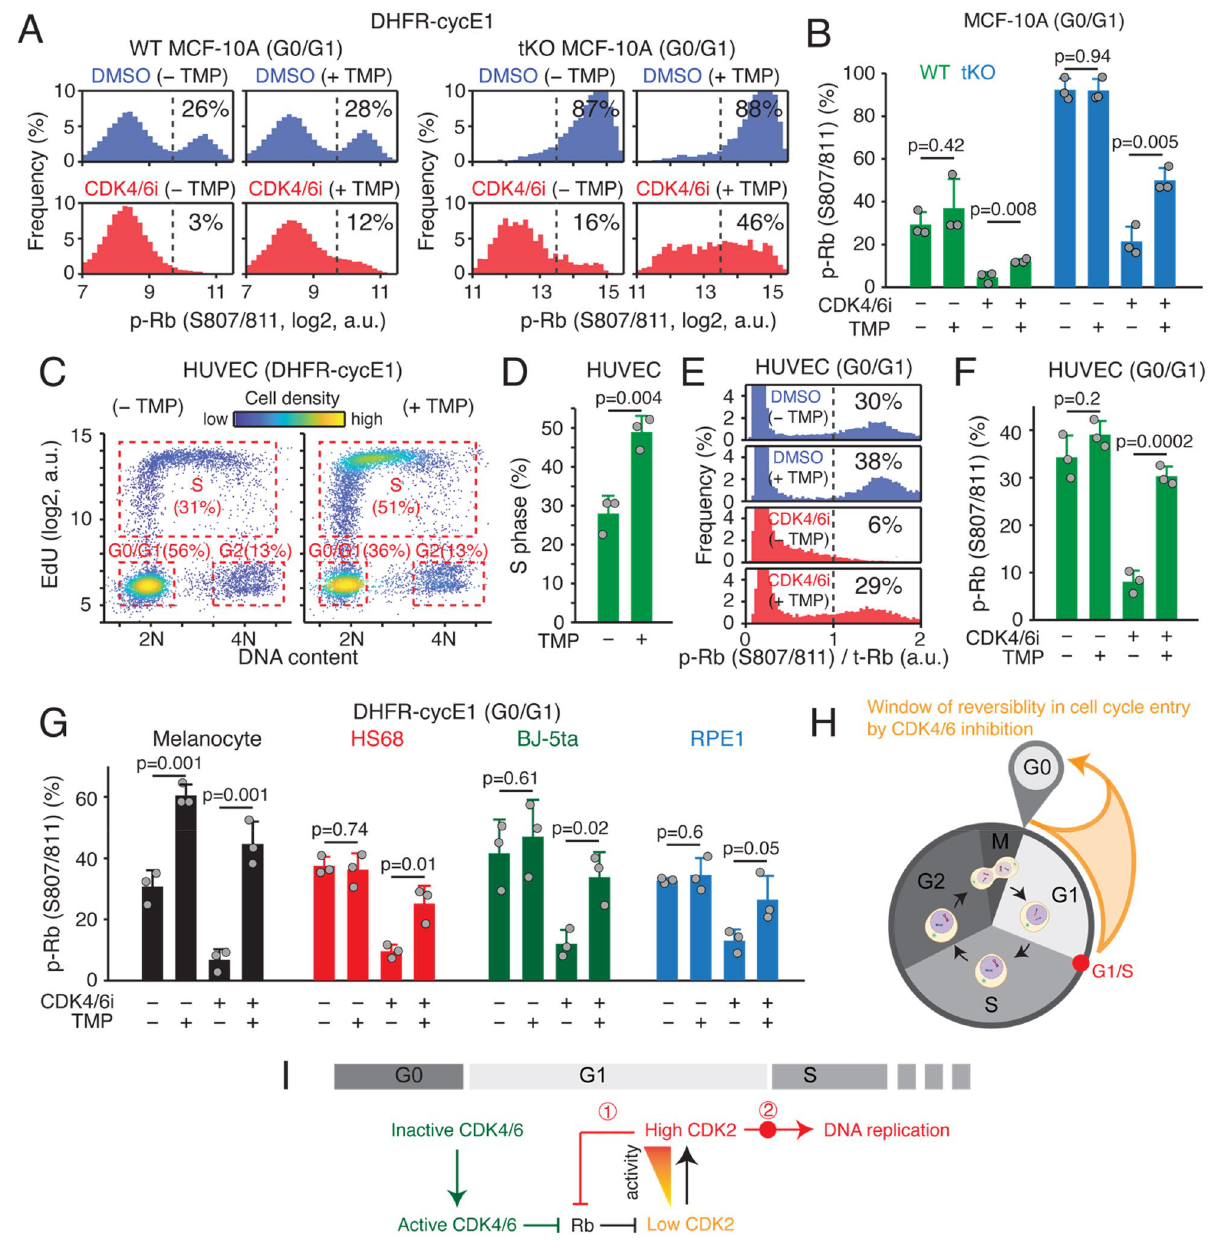
Figure 5. CDK2 activity regulates the timing of CDK2-Rb feedback and the G1/S transition. ( A , B ) Histogram ( A ) and the percentage ( B ) of p-Rb at S807/811 in wild type and p21/p27/p57 tKO MCF-10A cells with DHFR- cyclin E1 expression in G0/G1 phase. After 48 h mitogen removal, cells were stimulated with mitogens for 11 h with or without TMP (50 µM) followed by acute treatment with EdU (10 µM) ± palbociclib (1 µM) for 15 min prior to fixation. Data are mean ± s.d. ( n = 3 biological replicates) ( B ). P -values were calculated with two-sample t -tests. ( C , D ) Scatterplot of Hoechst versus EdU, where cell density is color-coded ( C ). The percentage of S phase cells ( D ). Cycling HUVECs expressing DHFR-cyclin E1 were treated with or without TMP (50 µM) for 6 h followed by EdU (10 µM) treatment for 15 min prior to fixation. Data are mean ± s.d. ( n = 3 biological replicates) ( D ). P -values were calculated with two-sample t -tests. ( E ) Histogram of p-Rb at S807/811 in cycling HUVEC cells expressing DHFR-cyclin E1 in G0/G1 phase. Cycling cells were treated with or without TMP (50 µM) for 6 h followed by acute treatment with palbociclib (1 µM) and EdU (10 µM) for 15 min prior to fixation. ( F , G ) Percentage of p-Rb at S807/811 for each treatment condition as indicated in HUVEC ( F ), Melanocyte, HS68, BJ-5ta, and RPE1 cells ( G ) expressing DHFR-cyclin E1 in G0/G1 phase. Data are mean ± s.d. ( n = 3 biological replicates). Cycling cells were treated with or without TMP (50 µM) for 6 h followed by treatment with palbociclib (1 µM) and EdU (10 µM) for 15 min prior to fixation. P -values were calculated with two- sample t -tests. ( H , I ) Schematic of sequential regulation of the Rb/E2F pathway by CDK4/6 and CDK2. CDK4/6 inactivates Rb to induce E2F activity and a gradual increase in CDK2 activity. High levels of CDK2 activation triggers CDK2-Rb feedback to commit to the cell cycle ① , then initiates DNA replication ②